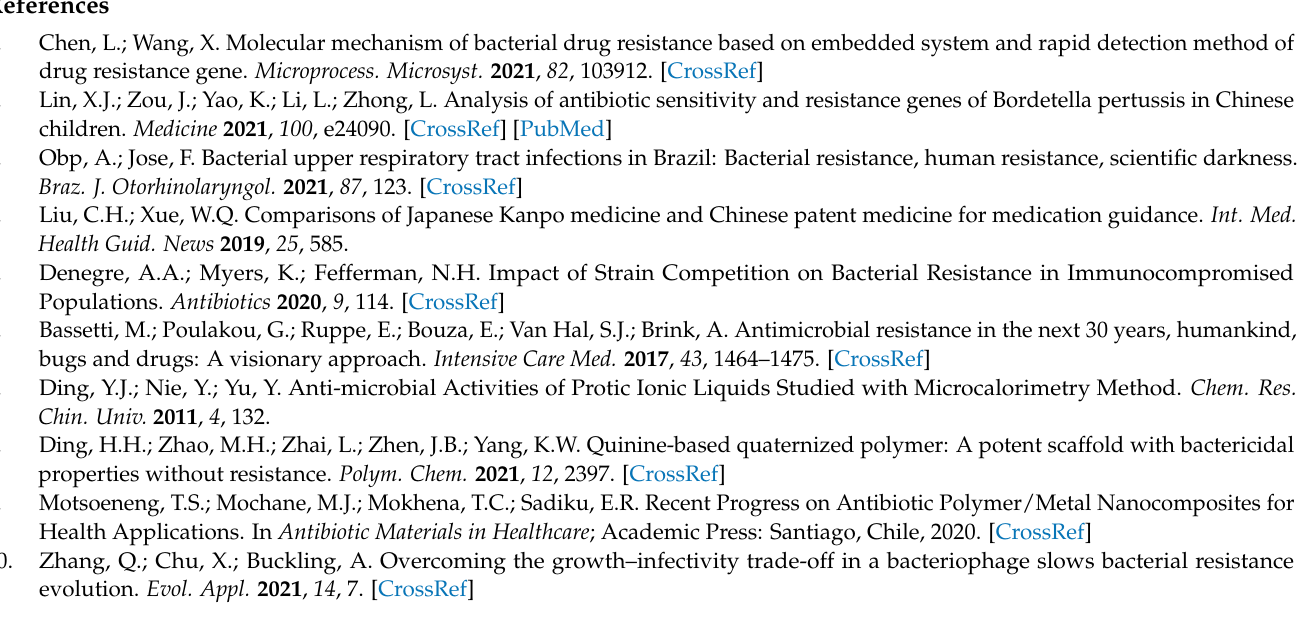
11b , Figure S8: 1 H NMR Spectrum of 11c , Figure S9: 13 C NMR Spectrum of 11c . Figure S10: ES- MS for compound 11c , Figure S11: 1 H NMR Spectrum of 11d , Figure S12: 13 C NMR Spectrum of 11d . Figure S13: ES-MS for compound 11d , Figure S14: 1 H NMR Spectrum of 11e , Figure S15: 13 C NMR Spectrum of 11e . Figure S16: ES-MS for compound 11e , Figure S17: 1 H NMR Spectrum of 11f , Figure S18: 13 C NMR Spectrum of 11f . Figure S19: ES-MS for compound 11f , Figure S20: 1 H NMR Spectrum of 11g , Figure S21: 13 C NMR Spectrum of 11g . Figure S22: ES-MS for compound 11g , Figure S23: 1 H NMR Spectrum of 11h , Figure S24: 13 C NMR Spectrum of 11h . Figure S25: ES-MS for compound 11h , Figure S26: 1 H NMR Spectrum of 11i , Figure S27: 13 C NMR Spectrum of 11i . Figure S28: ES-MS for compound 11i , Figure S29: 1 H NMR Spectrum of 12a , Figure S30: 13 C NMR Spectrum of 12a . Figure S31: ES-MS for compound 12a , Figure S32: 1 H NMR Spectrum of 12b , Figure S33: 13 C NMR Spectrum of 12b . Figure S34: ES-MS for compound 12b , Figure S35: 1 H NMR Spectrum of 12c , Figure S36: 13 C NMR Spectrum of 12c . Figure S37: ES-MS for compound 12c , Figure S38: 1 H NMR Spectrum of 12d , Figure S39: 13 C NMR Spectrum of 12d . Figure S40: ES-MS for compound 12d , Figure S41: 1 H NMR Spectrum of 12e , Figure S42: 13 C NMR Spectrum of 12e . Figure S43: ES-MS for compound 12e , Figure S44: 1 H NMR Spectrum of 12f , Figure S45: 13 C NMR Spectrum of 12f . Figure S46: ES-MS for compound 12f , Figure S47: 1 H NMR Spectrum of 12g , Figure S48: 13 C NMR Spectrum of 12g . Figure S49: ES-MS for compound 12g , Figure S50: 1 H NMR Spectrum of 12h , Figure S51: 13 C NMR Spectrum of 12h . Figure S52: ES-MS for compound